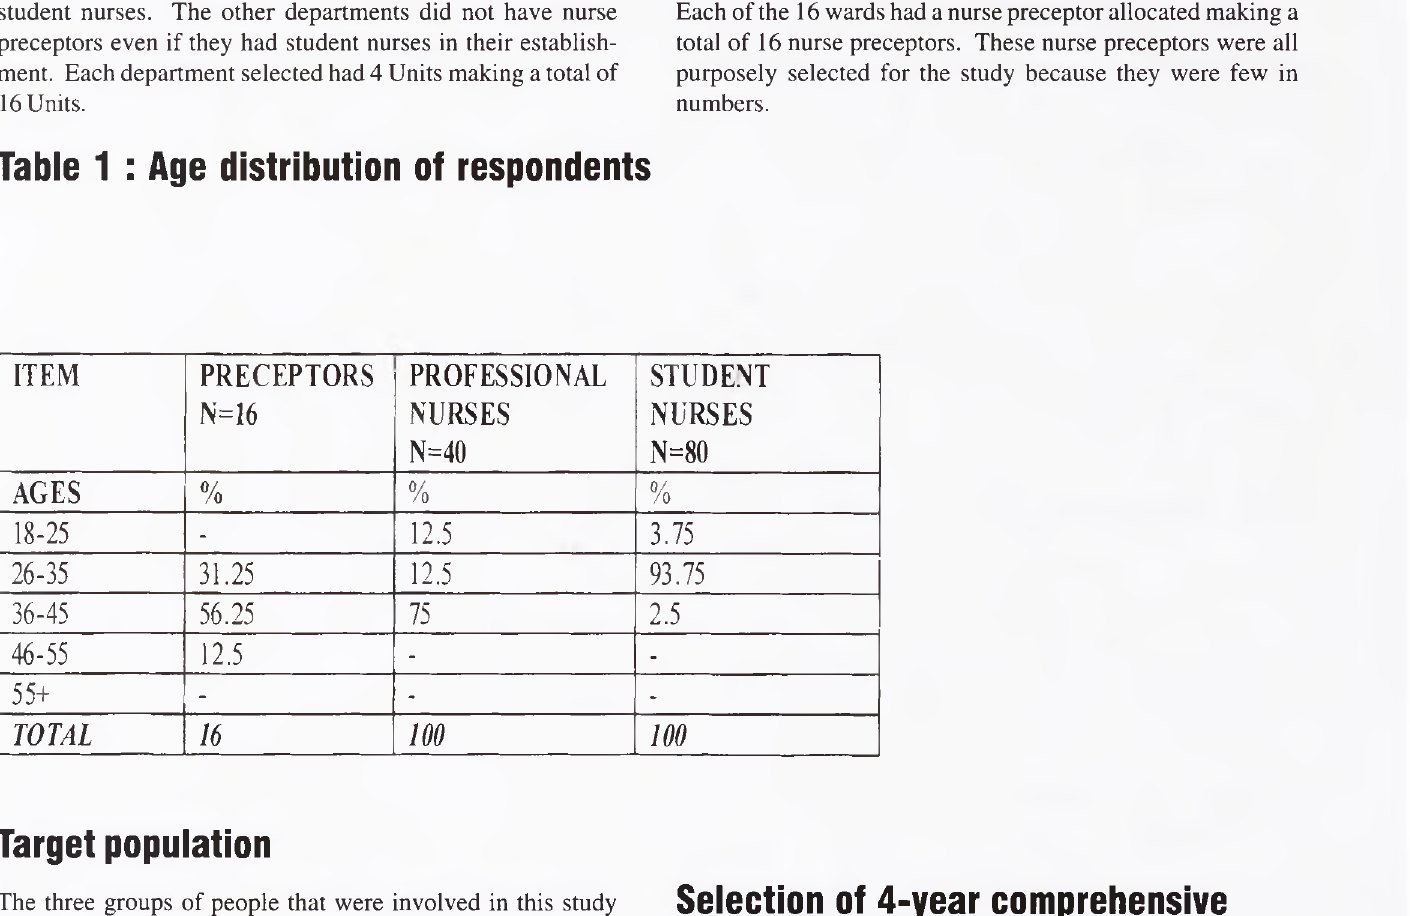
Table 1 : Age distribution of